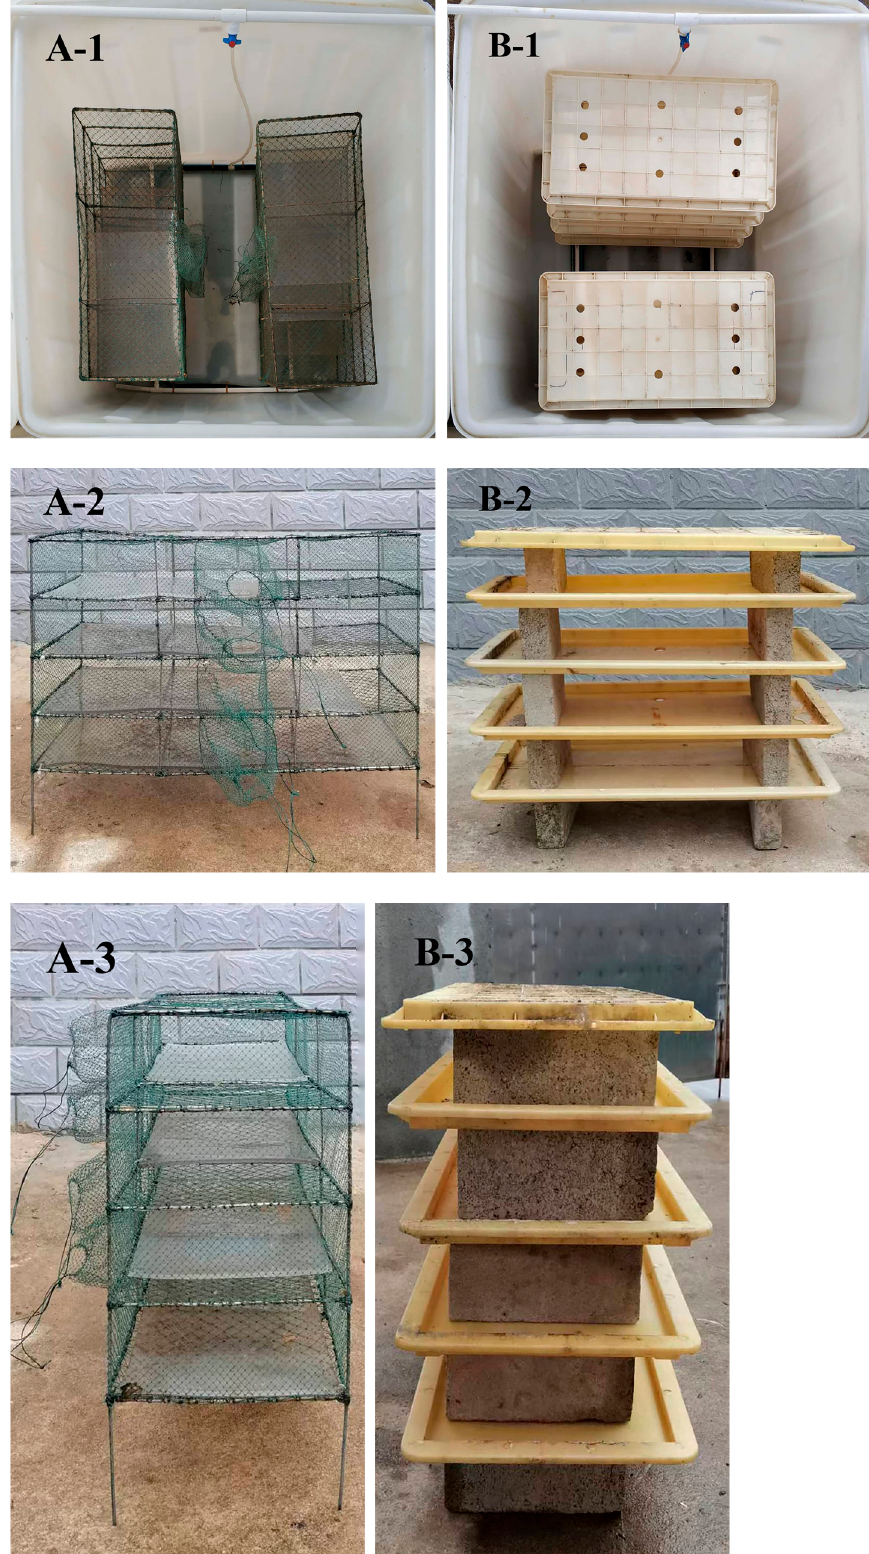
Figure 1. Top view image of the closed shelter ( A-1 ) and the open shelter ( B-1 ); front view image of the closed shelter ( A-2 ) and the open shelter ( B-2 ); lateral view image of the closed shelter ( A-3 ) and the open shelter ( B-3 ).